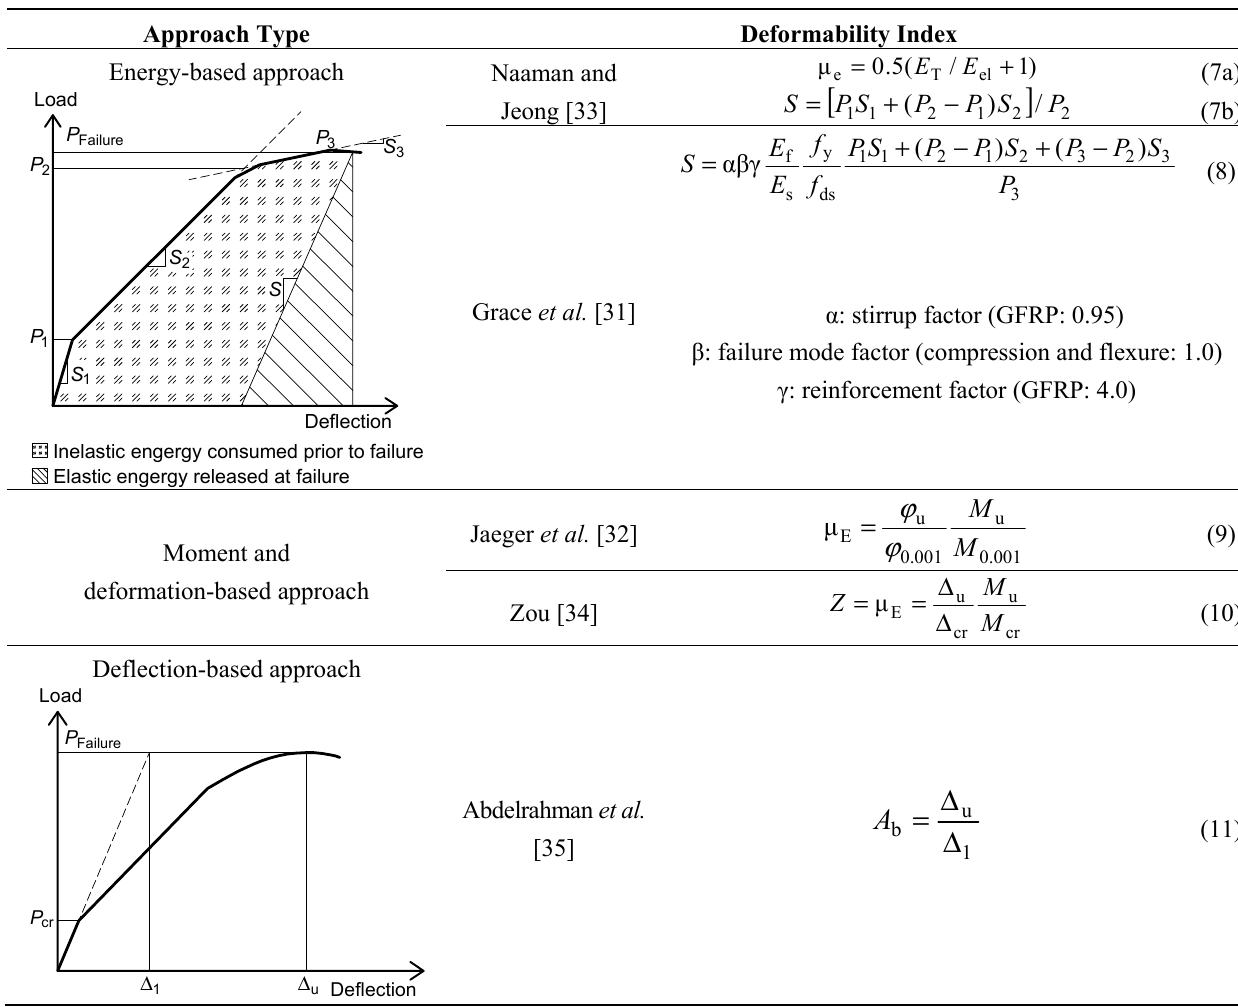
Table 5. Deformability